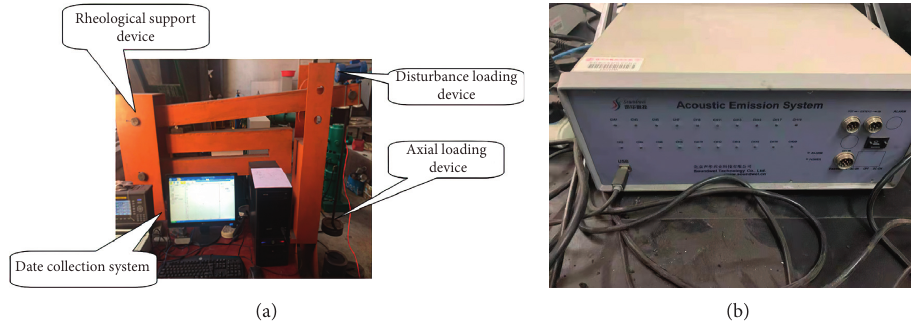
Figure 1: Testing system: (a) rheological testing system; (b) AE system.